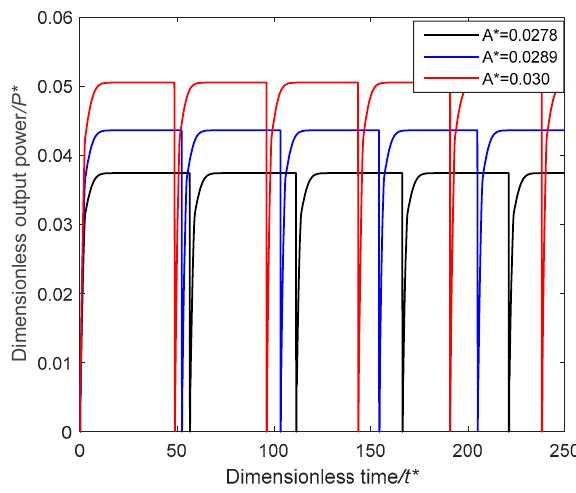
Figure 9. Dimensionless output power–time curves of the power system.